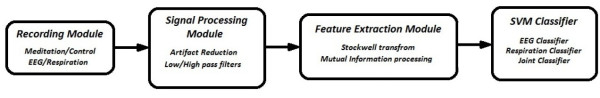
Classification process flow chart.